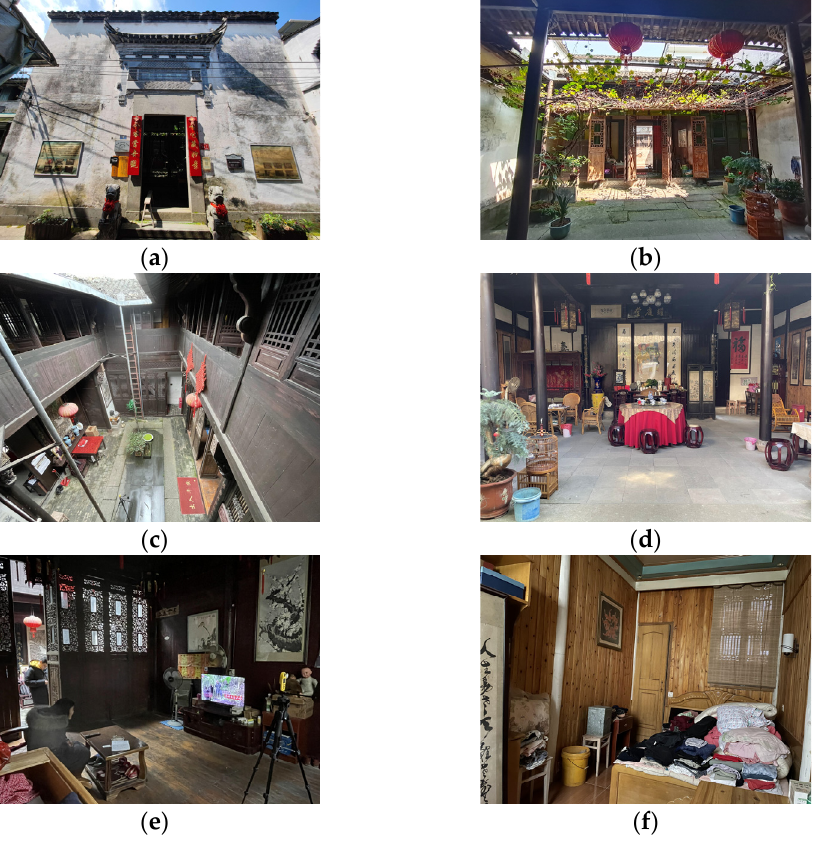
Figure 5. Photographs of the interior of the “Yao’s House”. ( a ) Building front elevation. ( b ) Front patio. ( c ) Hall. ( d ) Rear patio. ( e ) Rear hall. ( f ) Bedroom.